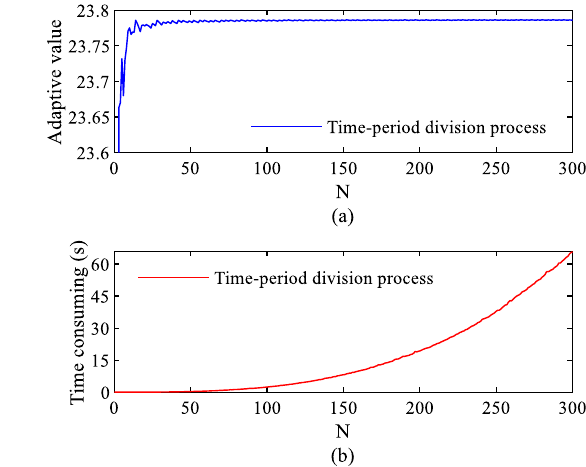
Fig. 3 Iterative process of period